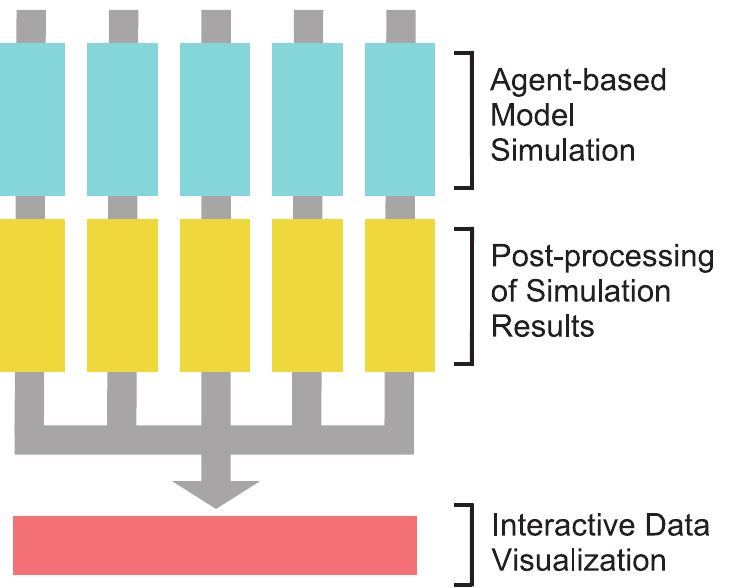
Fig 1. A flow chart of MASSIVE. Agent-based simulations and the following-post processing step are performed in parallel by employing a supercomputer. Results are then collected and subjected to interactive data visualization.